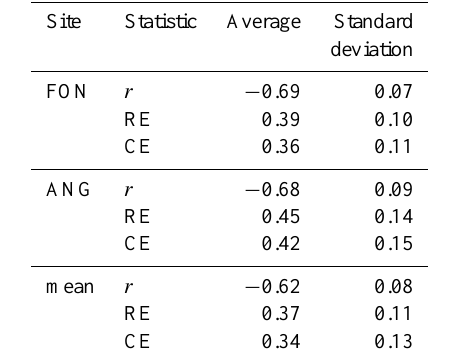
Table 3. Comparison of reconstructed and observed drought index SPEI: correlation coefficient ( r ), reduction of error statistic (RE) and coefficient of efficiency (CE). To calculate these statistics, the data were divided into randomly selected calibration (two-thirds) and verification (one-third) data sets. The given values are the aver- ages and standard deviations of 1000 iterations of this